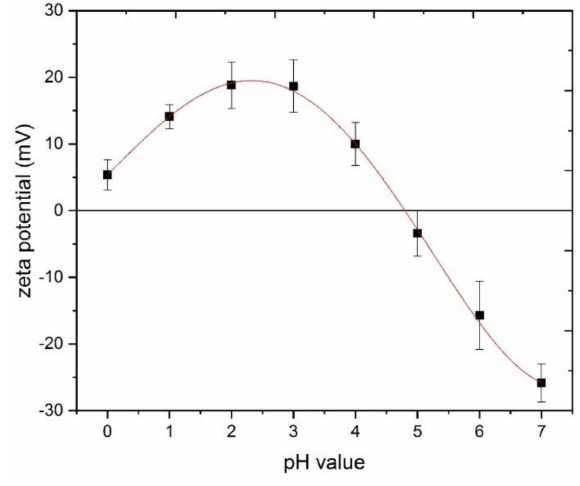
Figure 7. Zeta potential as a function of the pH values.